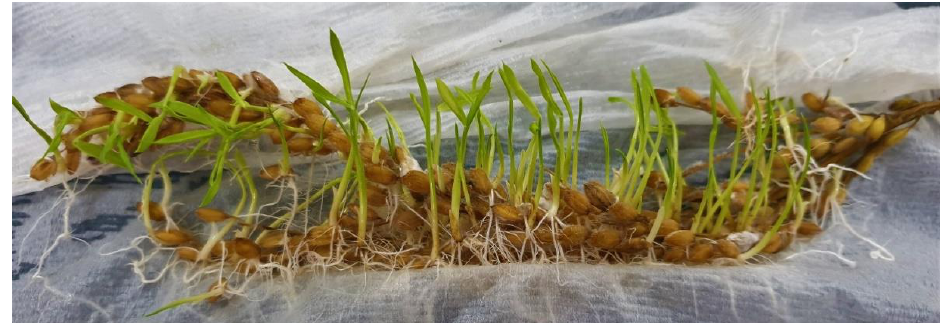
Figure 1. Pre-harvest sprouting of temperate japonica rice harvested at 20 days after flowering on the Zeigler Experiment Station of the International Rice Research Institute, Philippines, in the 2019 dry